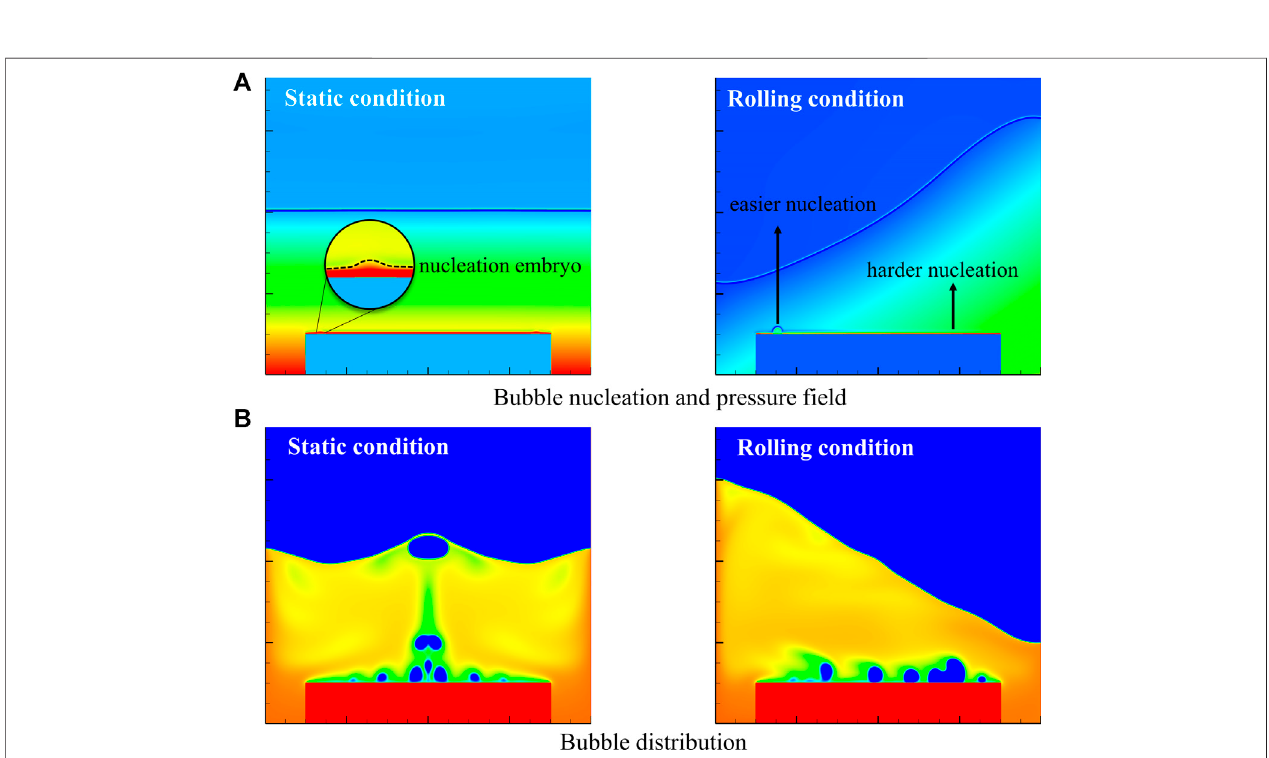
FIGURE 7 | Bubble nucleation and distribution under both static and rolling conditions.